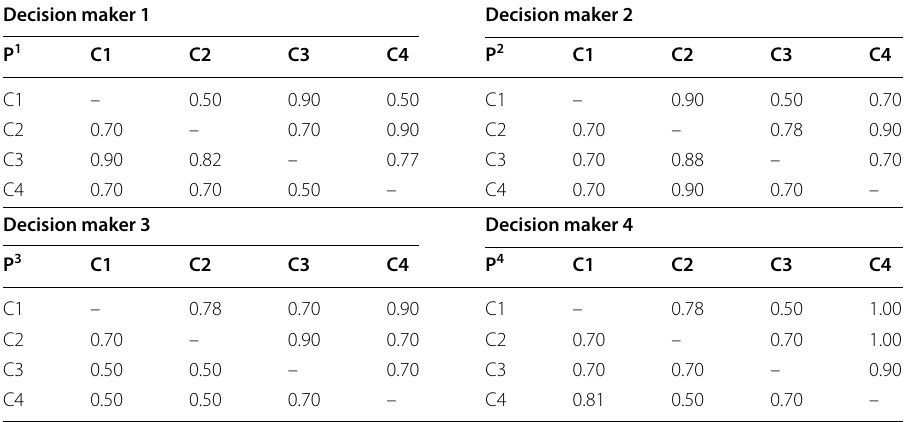
Table 12 Consensus-based fuzzy preference relations for the reward-based crowdfunding alternative (the second-round evaluation) Decision maker